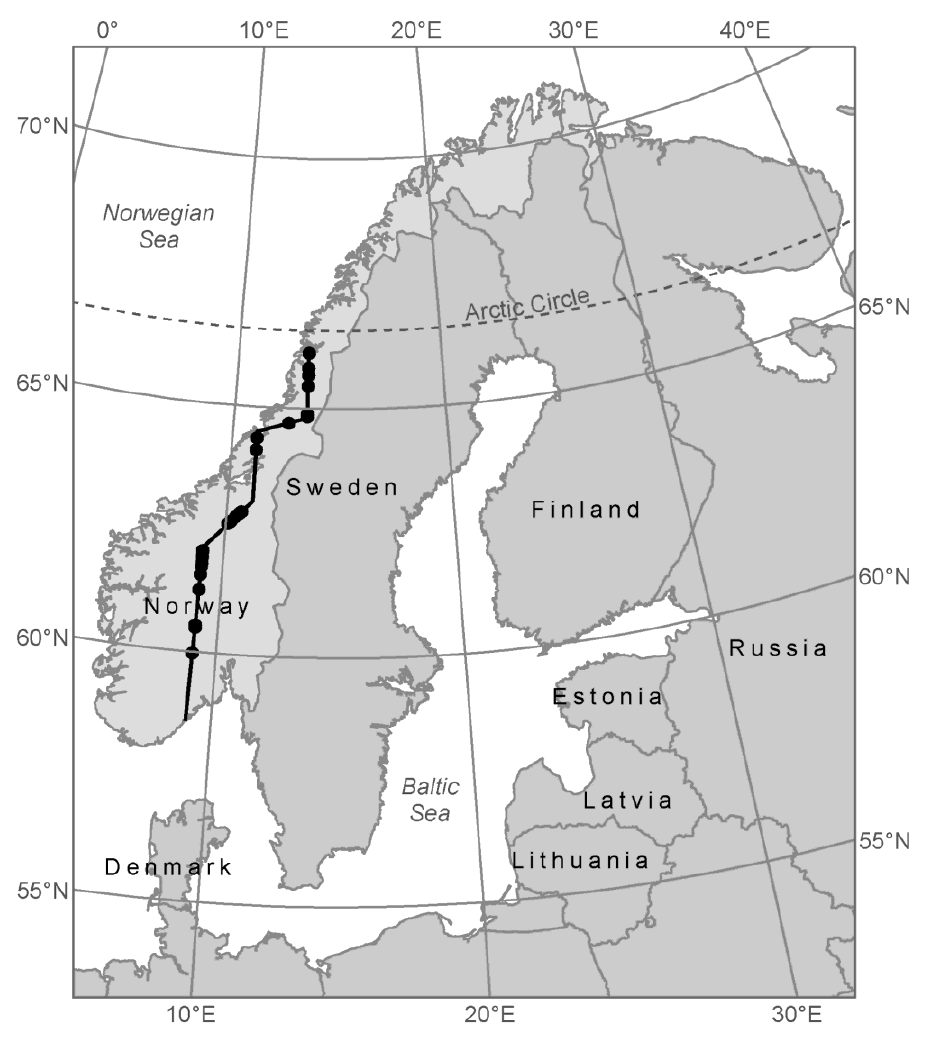
Figure 1. Overview of the study area with the 25 specific field sites (black points). The 1000 km long transect (black line) stretches from to 66°19′N 14°9′E to 58°3′N